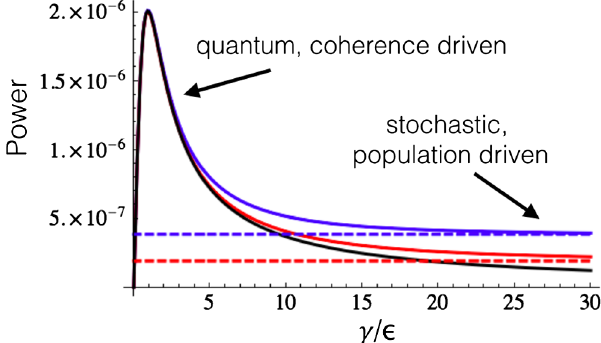
FIG. 10. The over-thermalization effect is the decrease of power when the thermalization rate is increased. Over-thermalization degrades the coherent work extraction mechanism without affecting the stochastic work extraction mechanism. When the coherent mechanism gets weak enough, the power is dominated by the stochastic power extraction mechanisms and power saturation is observed (dashed lines). The continuous engine has no stochastic work extraction mechanism, and therefore, it decays to zero without reaching